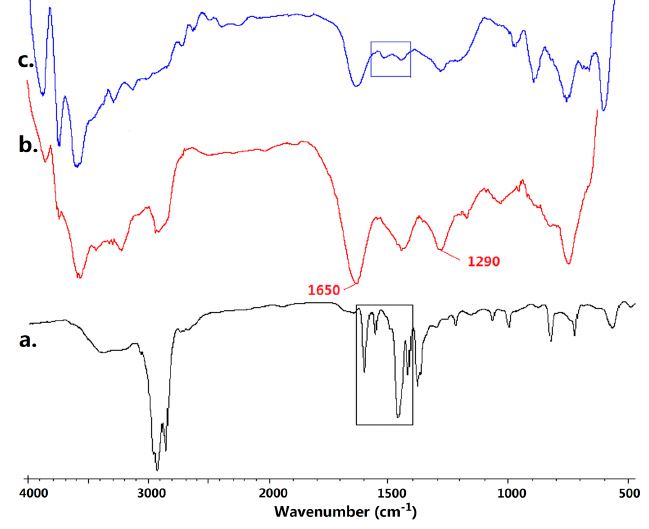
Figure 1. FTIR spectra of ( a ) poly(4-vinyl pyridine); ( b ) poly(4VP- co -NVP); and ( c ) poly(BVPC- co -NVP). Figure 2b. Spectrum of (a) in Figure 2 is the 1 H NMR spectrum of P4VP. Proton peaks present at